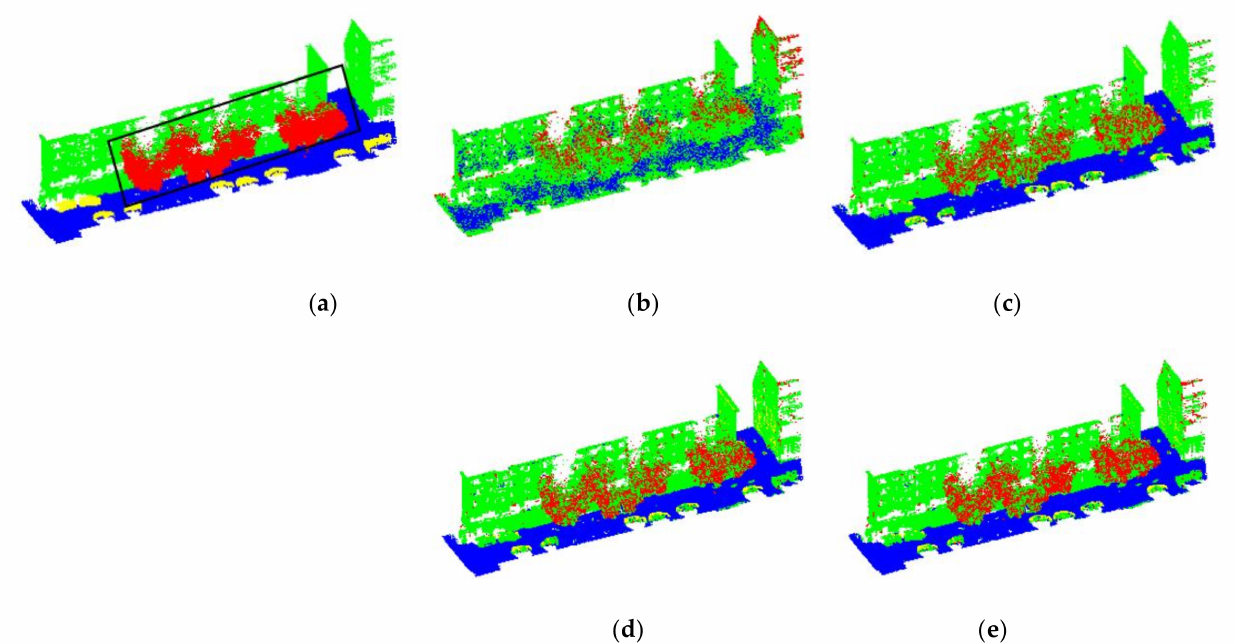
Figure 10. Classification results for Scene 2. ( a ) Ground truth; ( b ) Method 1; ( c ) Method 2; ( d ) Method 3; and ( e ) our method. Red, green, blue, and yellow points represent trees, buildings, floors, and cars, respectively.